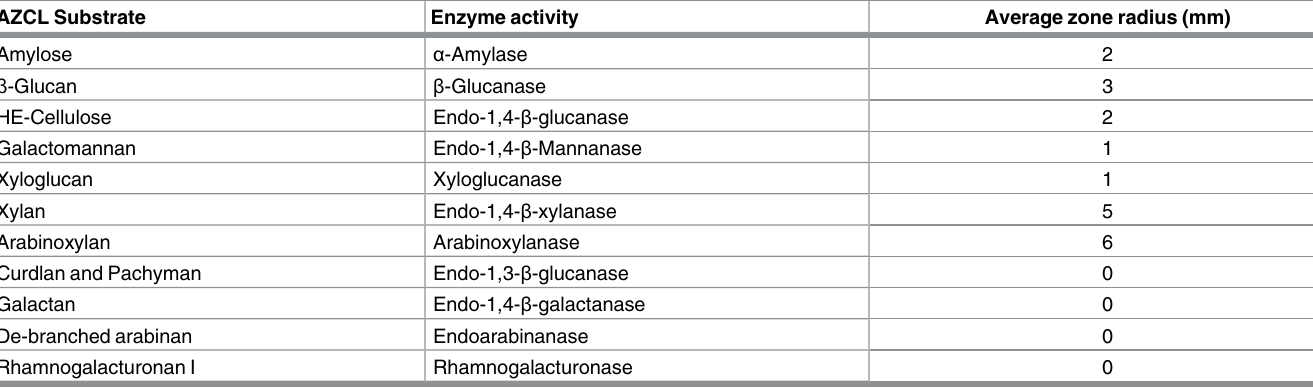
Table 2. Enzyme activity profile of liquid culture of Aspergillus hancockii FRR 3425 a